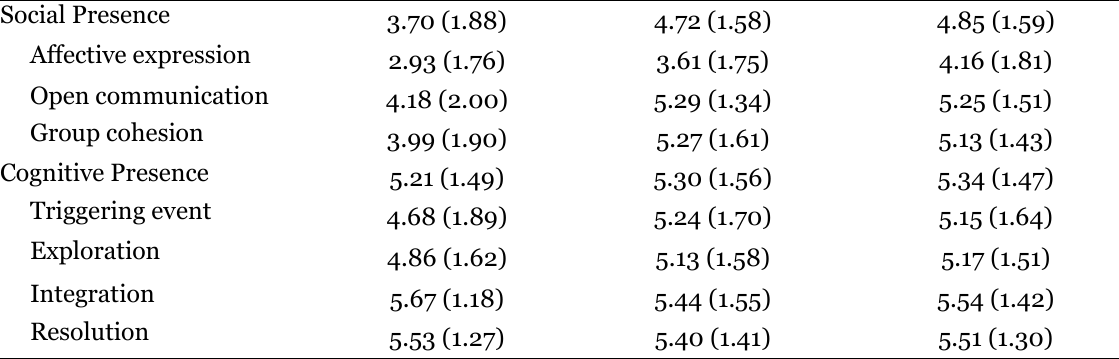
ANOVA Results for Community of Inquiry (CoI) Between Conditions